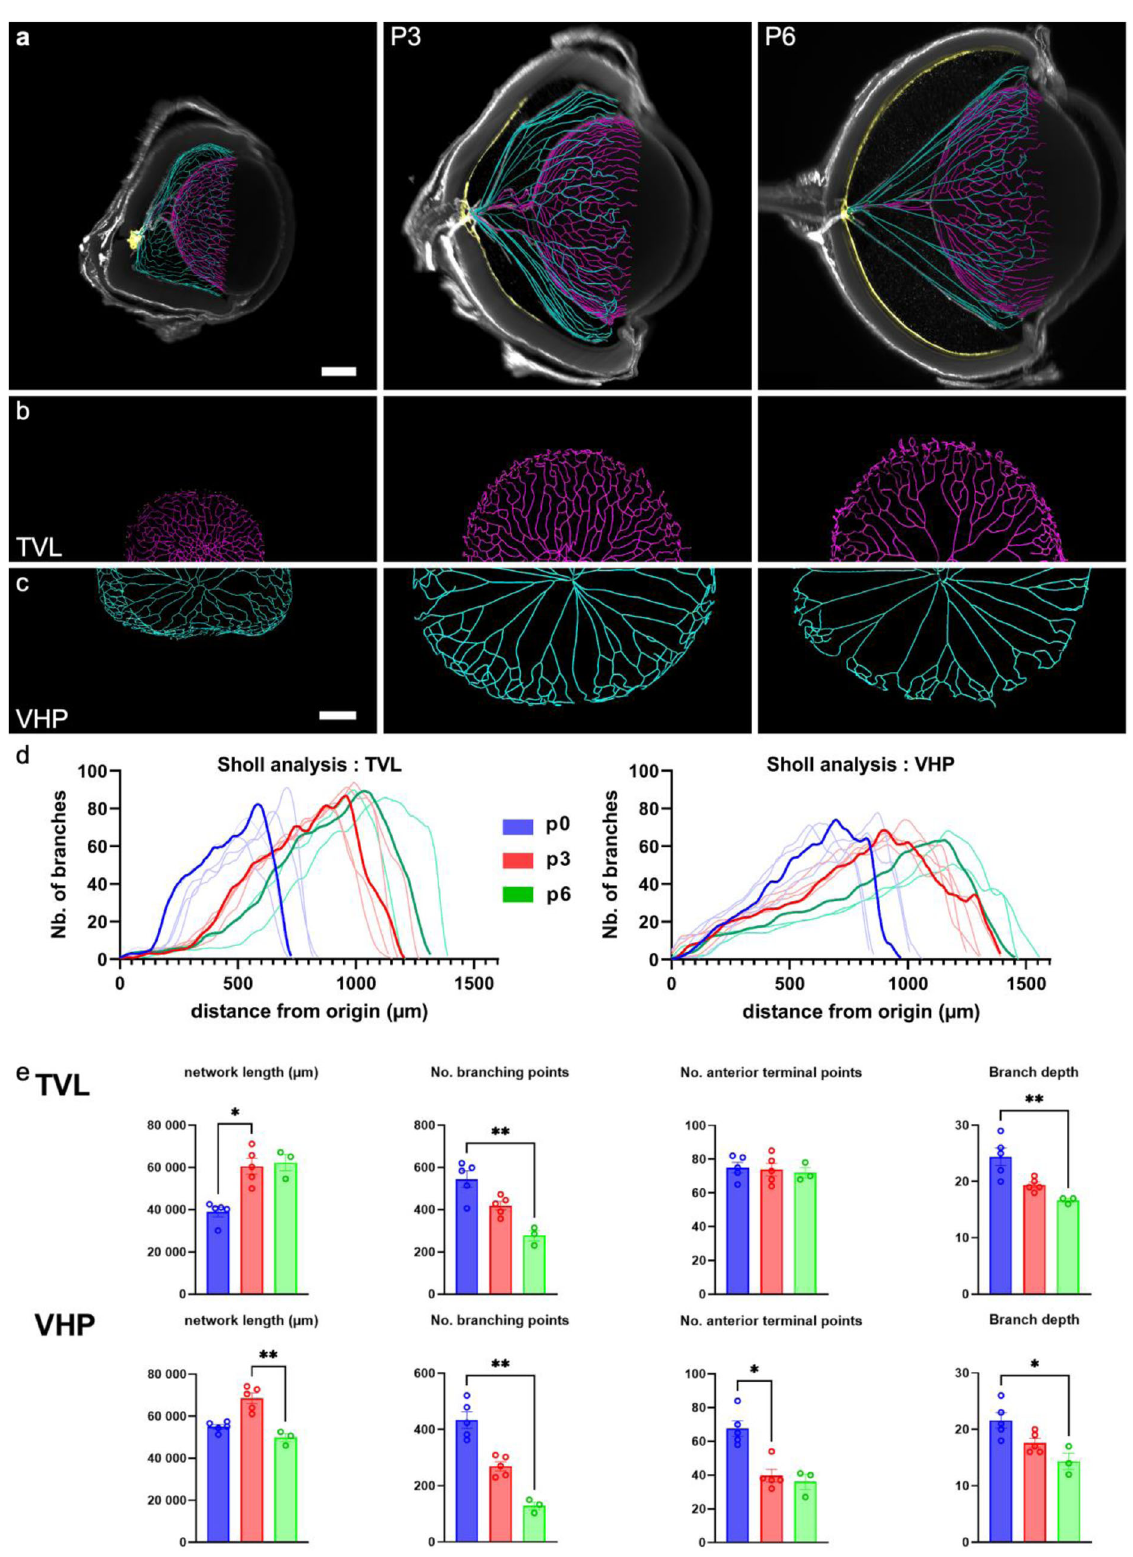
network, here de fi ned as the optic nerve. We conducted Sholl analysis of the HVP and TVL (Fig. 3a – c) at P0, P3 and P6 (Fig. 3d; from 4:14 to 4:28 in the video). The maximum number of branches remained rather constant from P0 to P6 (i.e. around 90 for TVL and 60 for VHP). Between P0 and P6 the overall length of VHP and TVL vessels increased, in parallel to